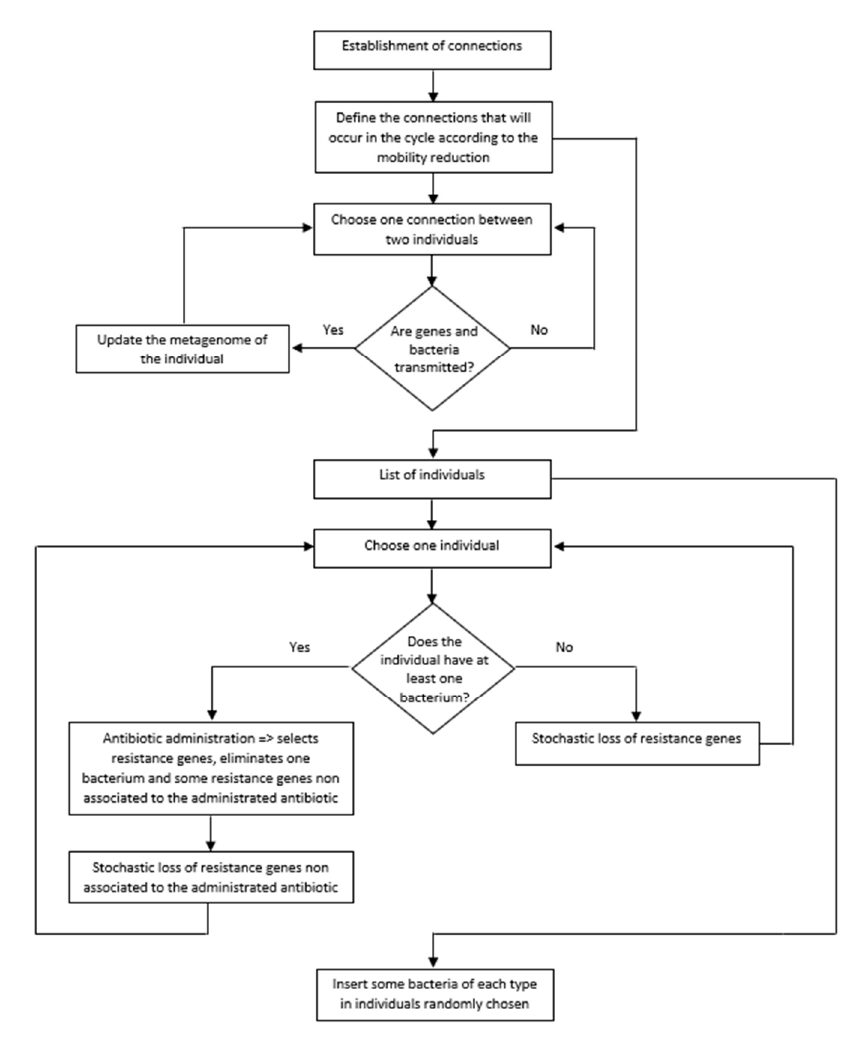
Figure 3. Flowchart of the algorithm of the